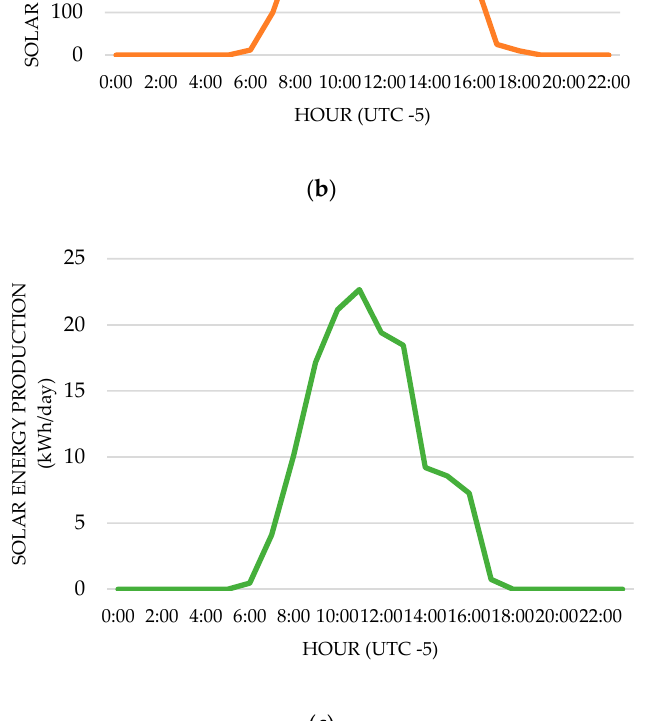
Figure 11. ( a ) Ambient temperature, ( b ) solar irradiance and ( c ) energy produced by the PV system on 17 November (time in hours corresponding to